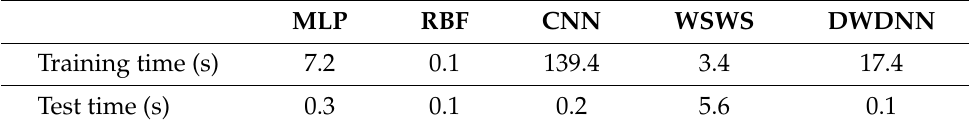
Table 9. Running time analysis with the Botswana